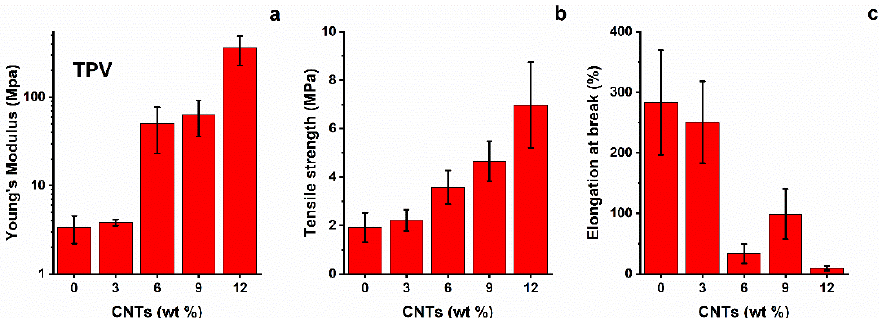
Figure 4. ( a ) Young ’ s modulus, ( b ) tensile strength, and ( c ) strain at break of TPV nanocomposites.